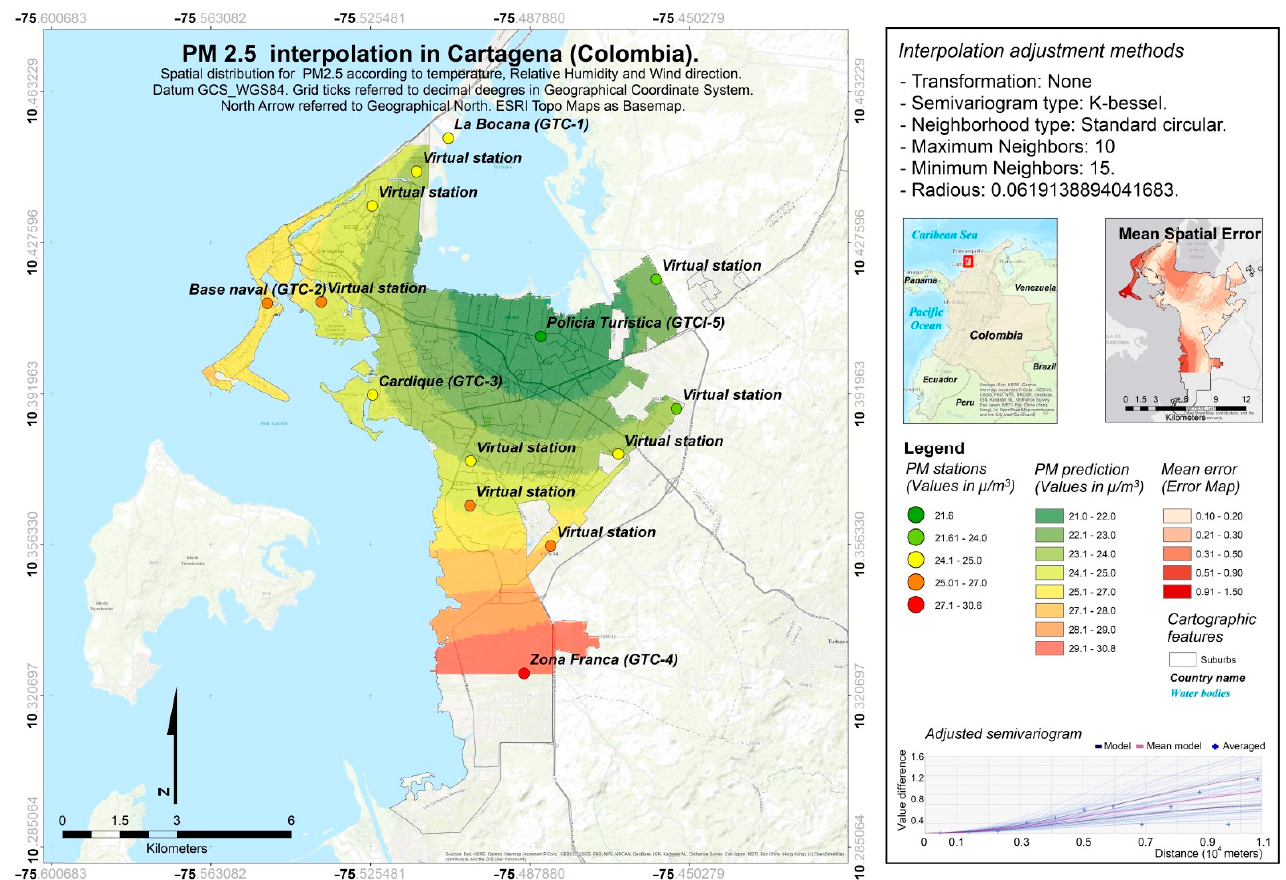
Figure 6. Improved spatial distribution of mean PM 2.5 (µg/m 3 ) in Cartagena (Colombia) .